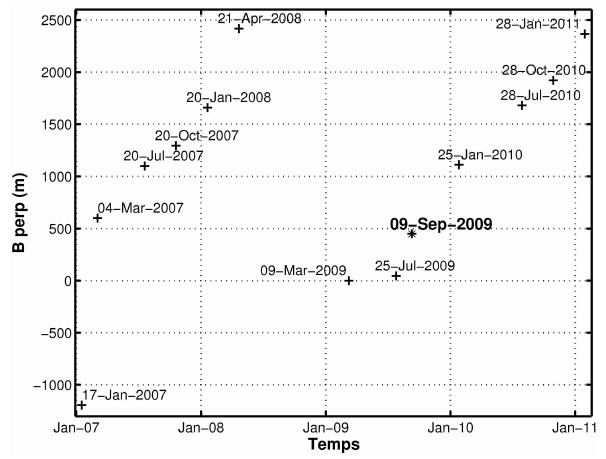
Figure 8. Available ALOS SAR images and their associated per- pendicular baselines. All slave images are linked to the best master image chosen in the middle of the time series that maximizes the sum correlation of all interferogram (Hooper et al., 2007).